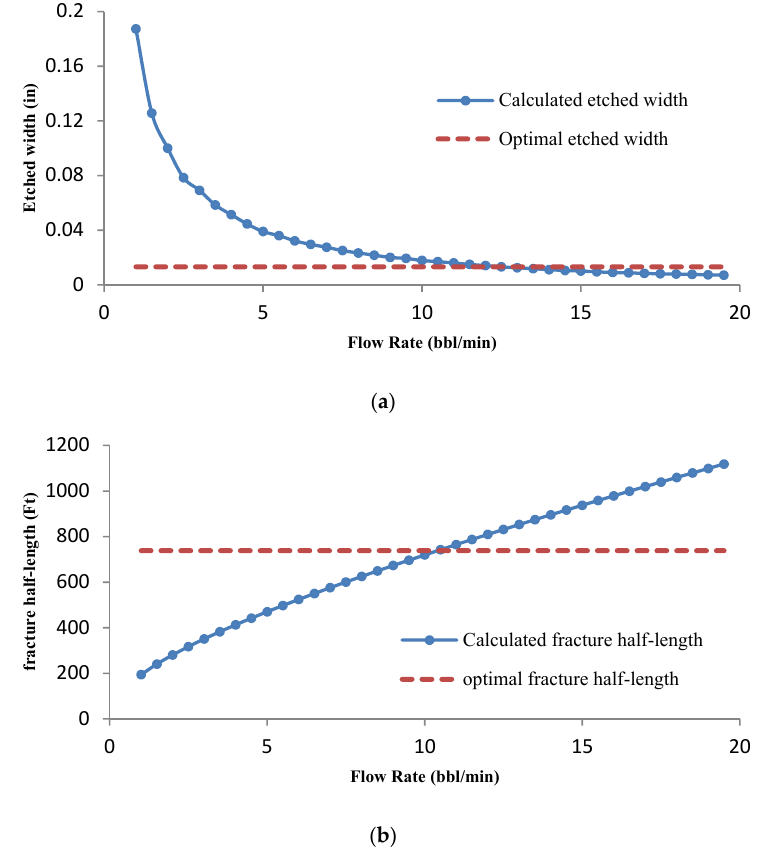
Figure 6. The average acid-etched width ( a ) and fracture half-length ( b ) versus injection flow rate.